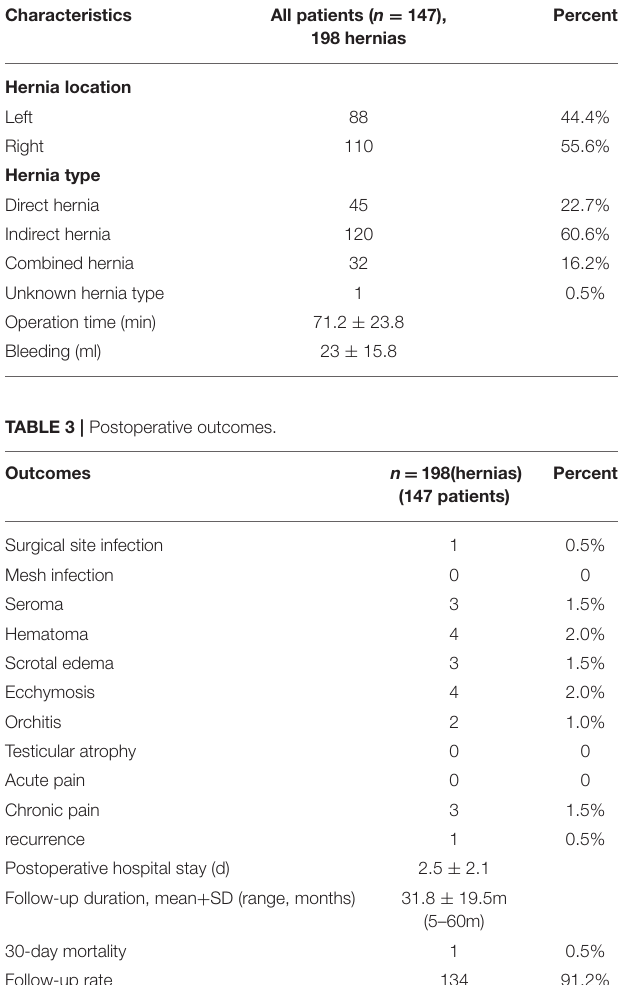
TABLE 2 | Hernia details in surgery. Characteristics